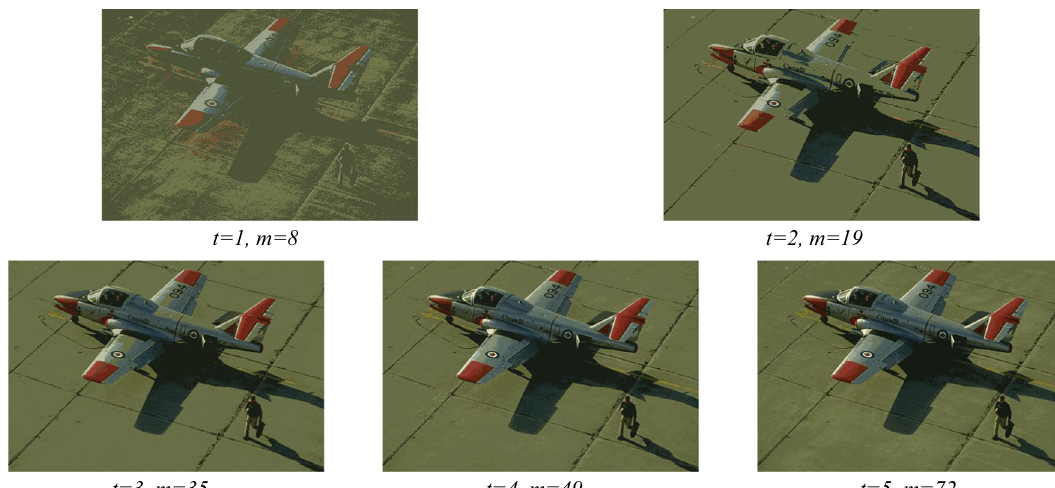
Fig. 13 Quantized 37073 image using